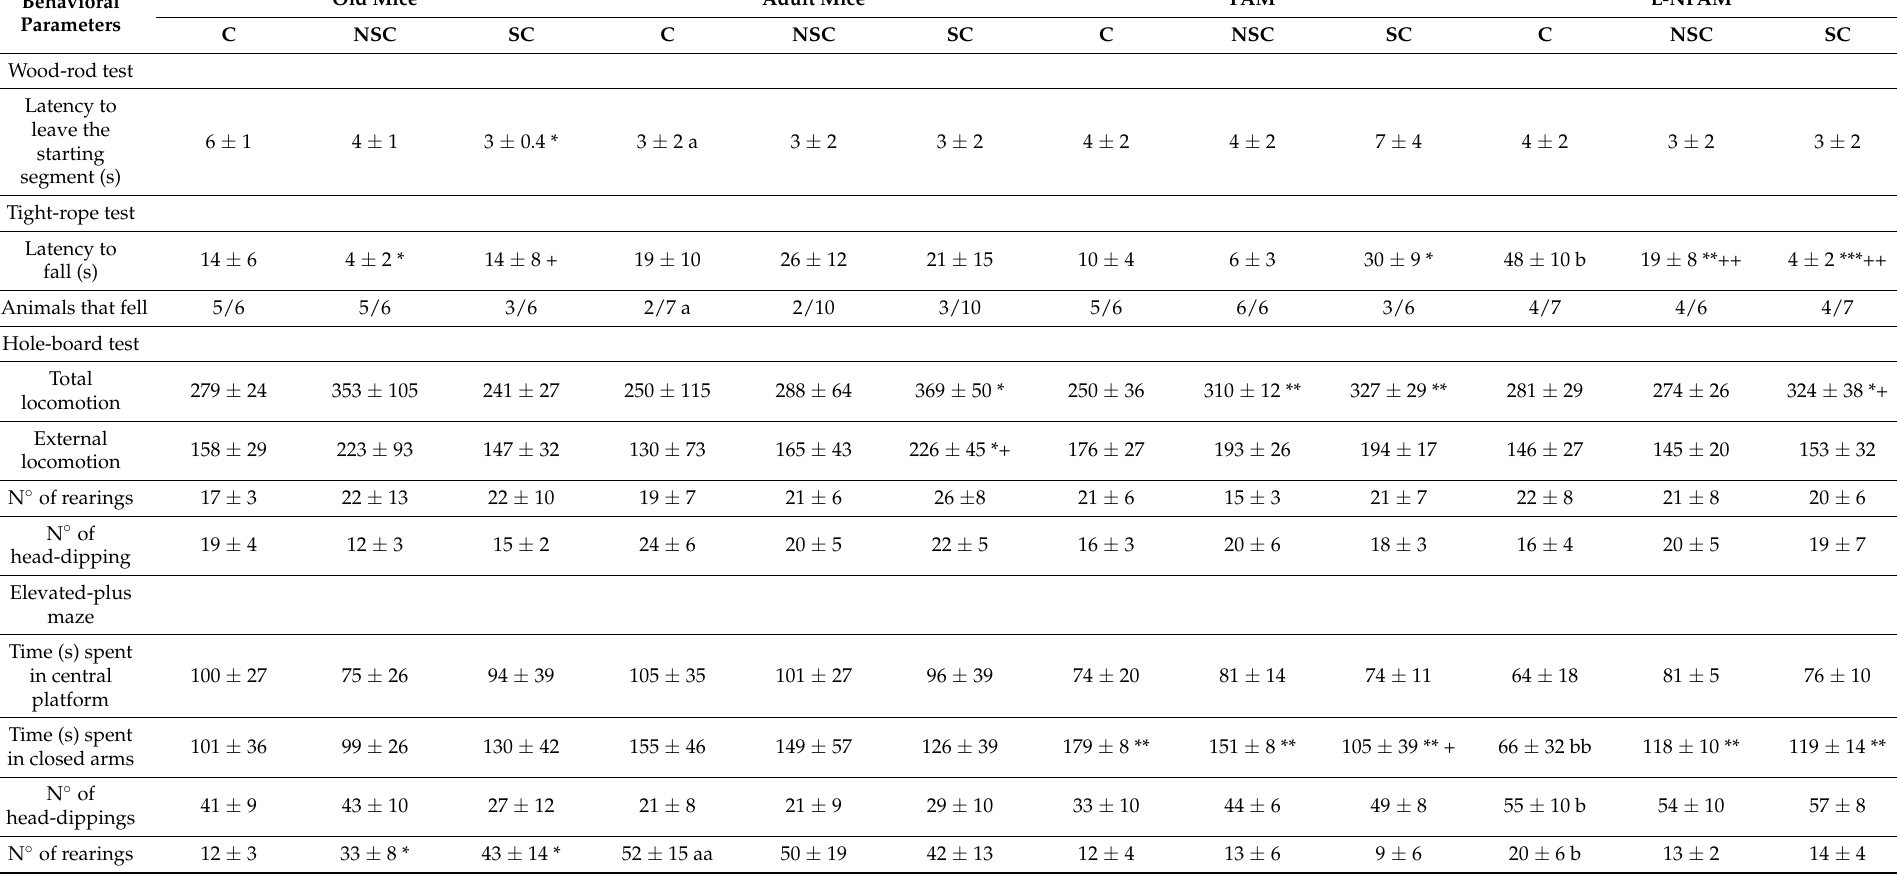
Table 1. Behavioral responses of old mice/PAM and adult mice/E-NPAM after cohabiting for 15 min/day for 2